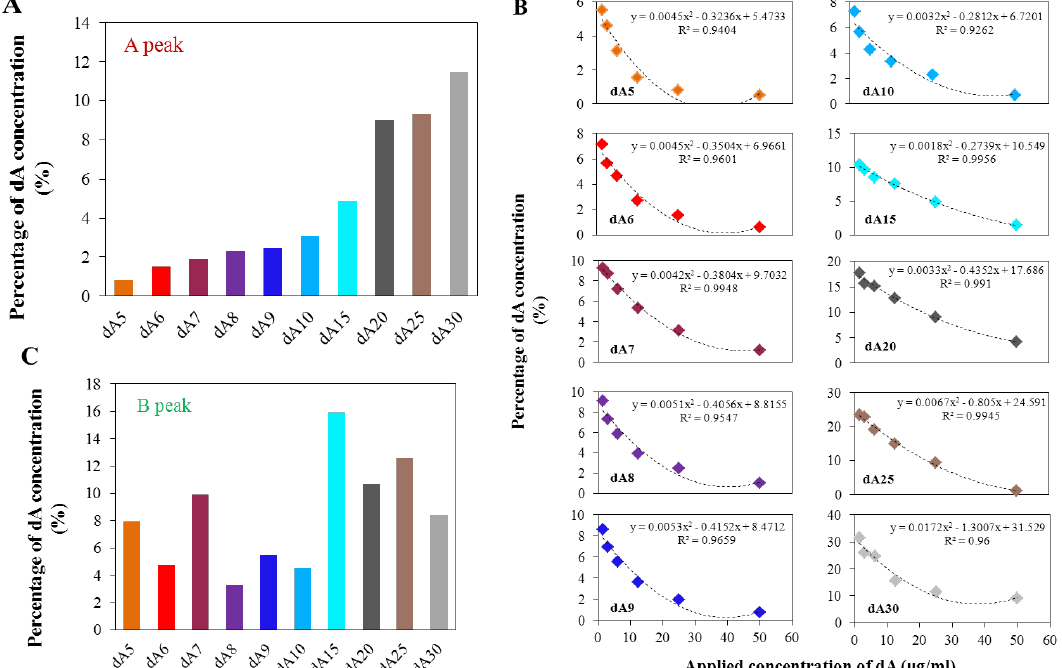
Figure 6. ( A ) Percentage of concentration of adenine nucleotides after isolation process (related to the applied concentration) depends on the number of adenine bases in strand—evaluation based on peak A; applied concentration of adenine nucleotide was 25 µg/mL; ( B ) Percentage of adenine nucleotides concentration after isolation process (related to the applied concentration) depends on applied concentration of adenine oligonucleotides—evaluation based on peak A; ( C ) Percentage of concentration of adenine nucleotides after isolation process (related to the applied concentration) depends on number of adenine bases in strand—evaluation based on peak B; applied concentration of adenine nucleotide was 25